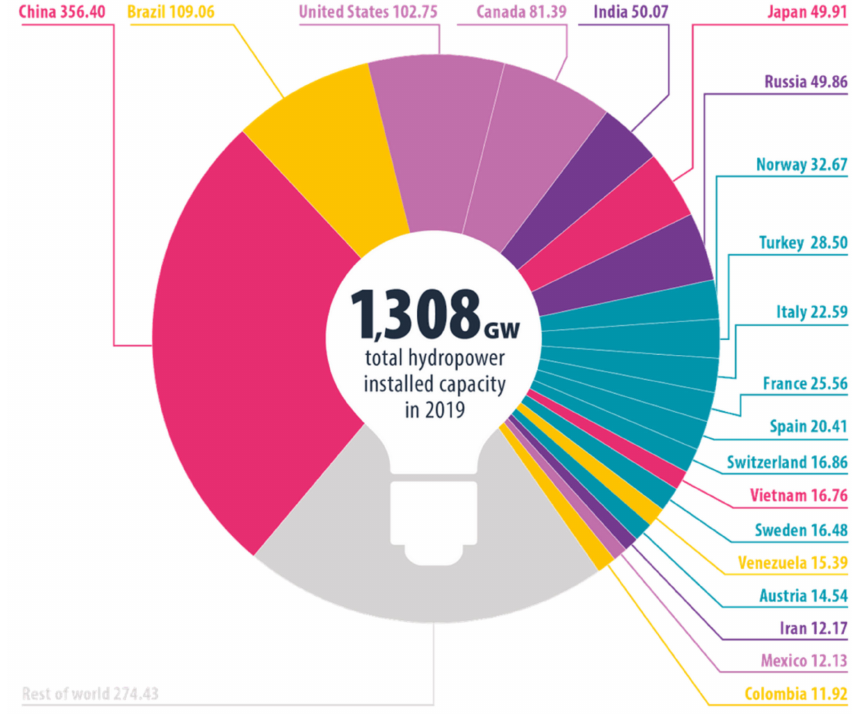
Figure 14. Total installed hydropower capacity (Source: International Hydropower Associa- tion,